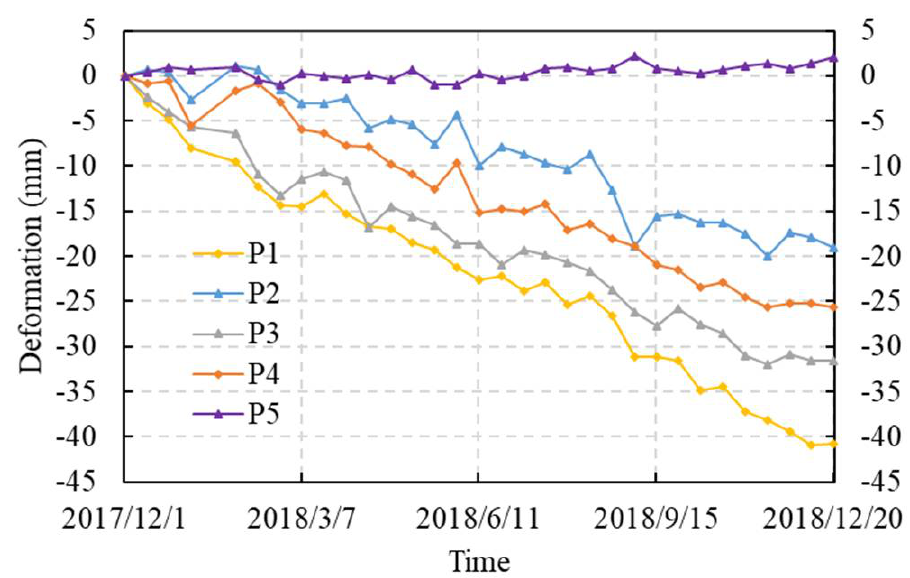
Figure 7. Accumulative time series deformation corresponding to feature points P1–P5, as marked in Figure 6.